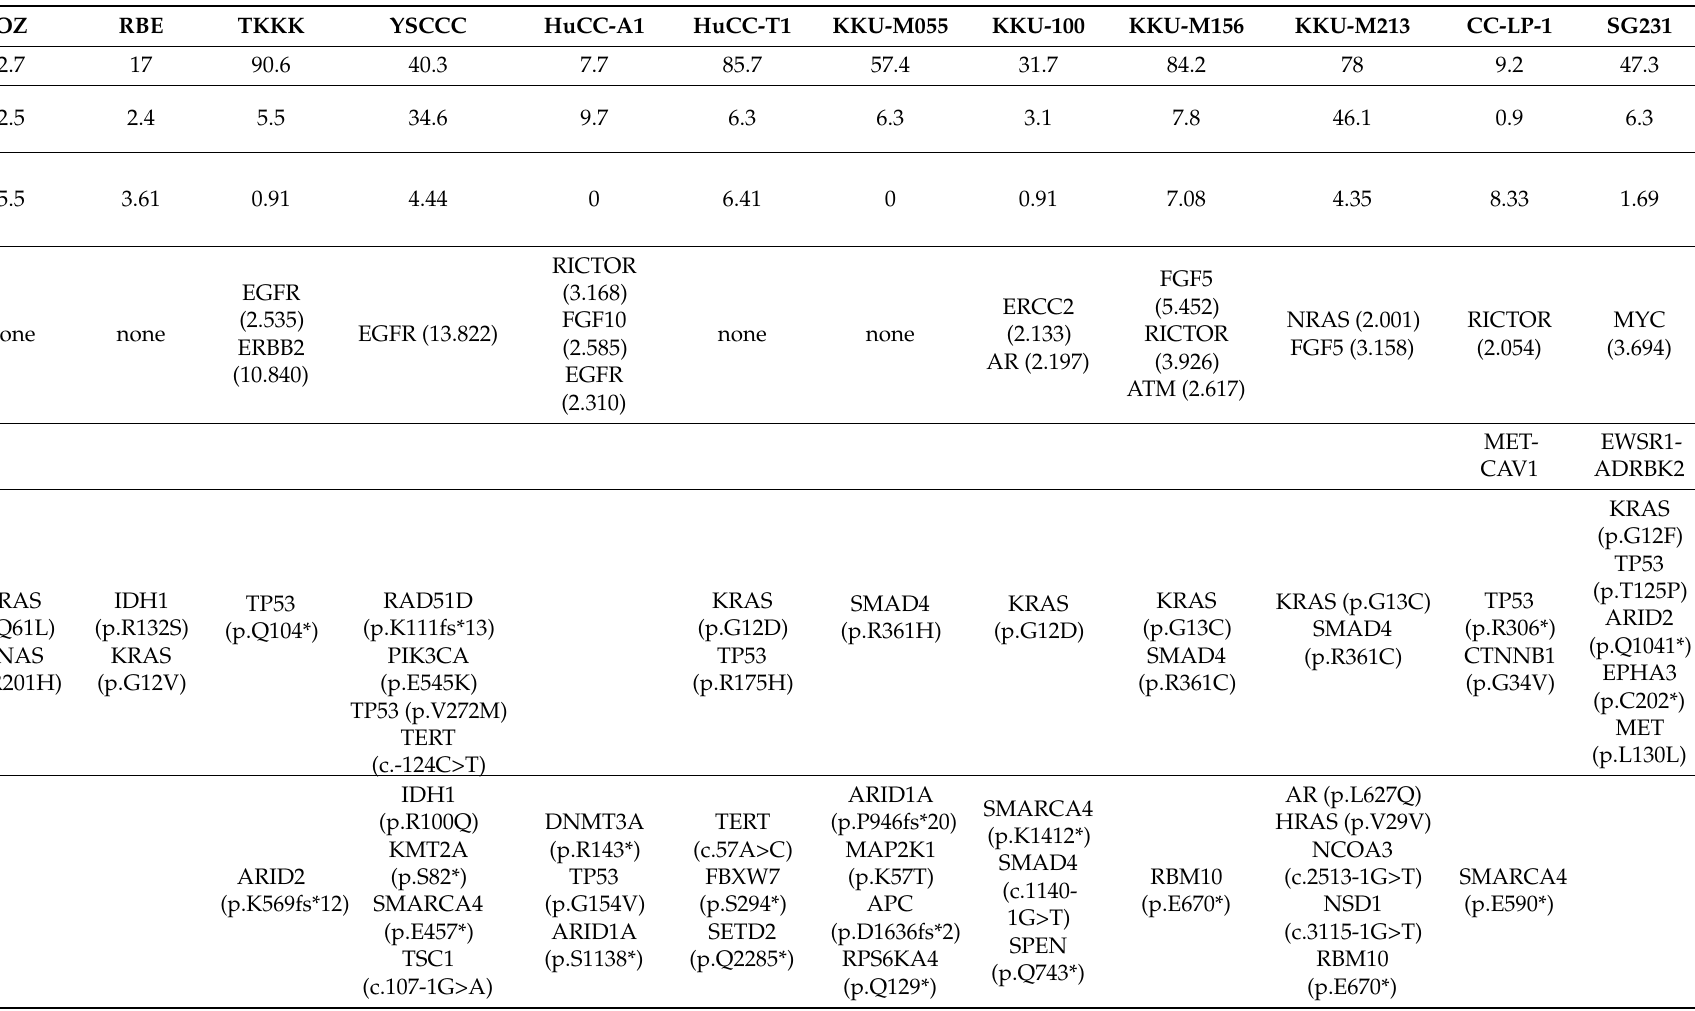
Table 3. Overview of the genetic profiling of CCA cell lines. Qiagen Clinical Insight ®